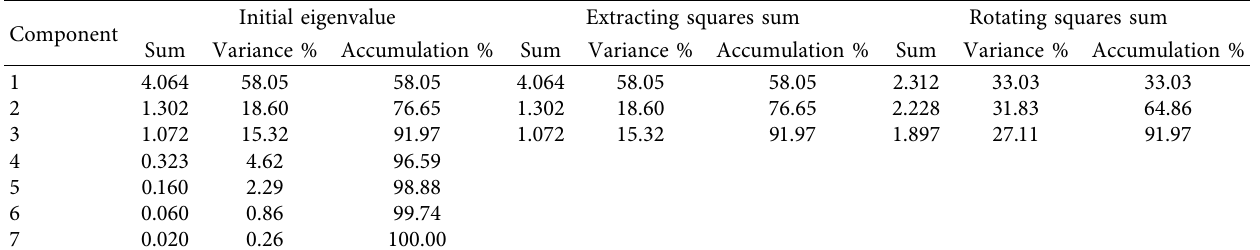
Table 7: Principal component analysis interpretation variables of sterols in sediments of the Guanting Reservoir. Initial eigenvalue Extracting squares sum Rotating squares sum Component